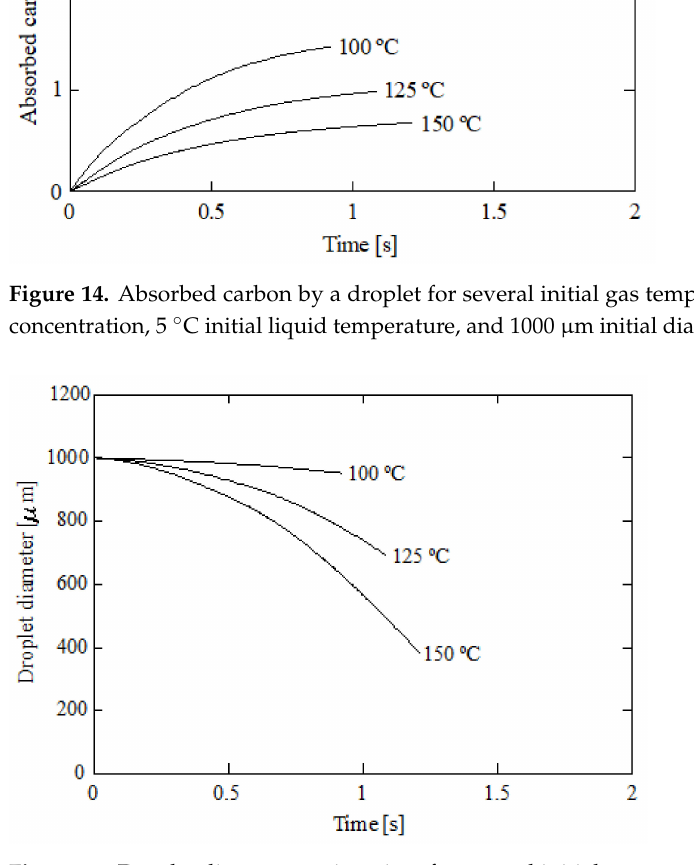
Figure 15. Droplet diameter against time for several initial gas temperatures; 5% initial ammonia concentration, 5 ◦ C initial liquid temperature, and 1000 µ m initial